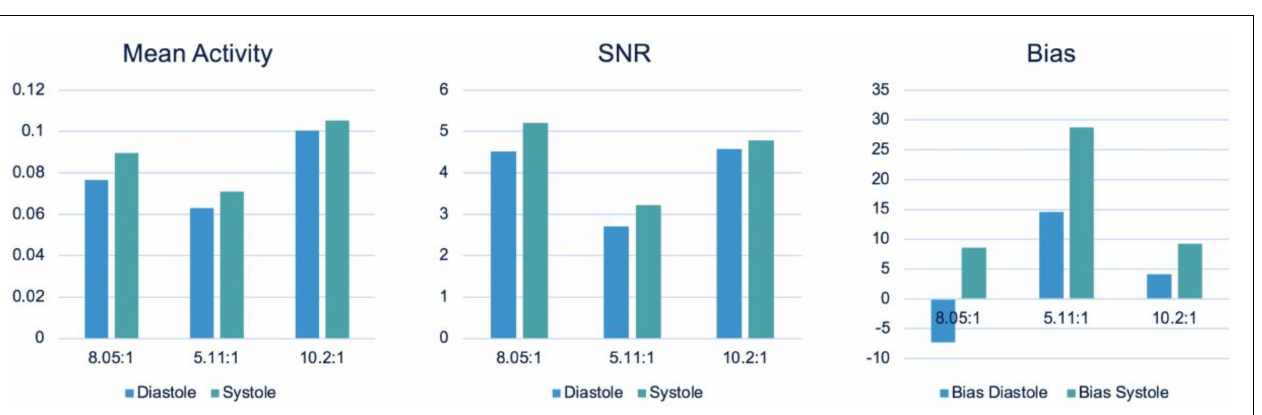
FIGURE 12 | Performance evaluation: Mean Stabilized Activity (MSA), SNR and Bias for three different TBRs for myocardium and systole and diastole